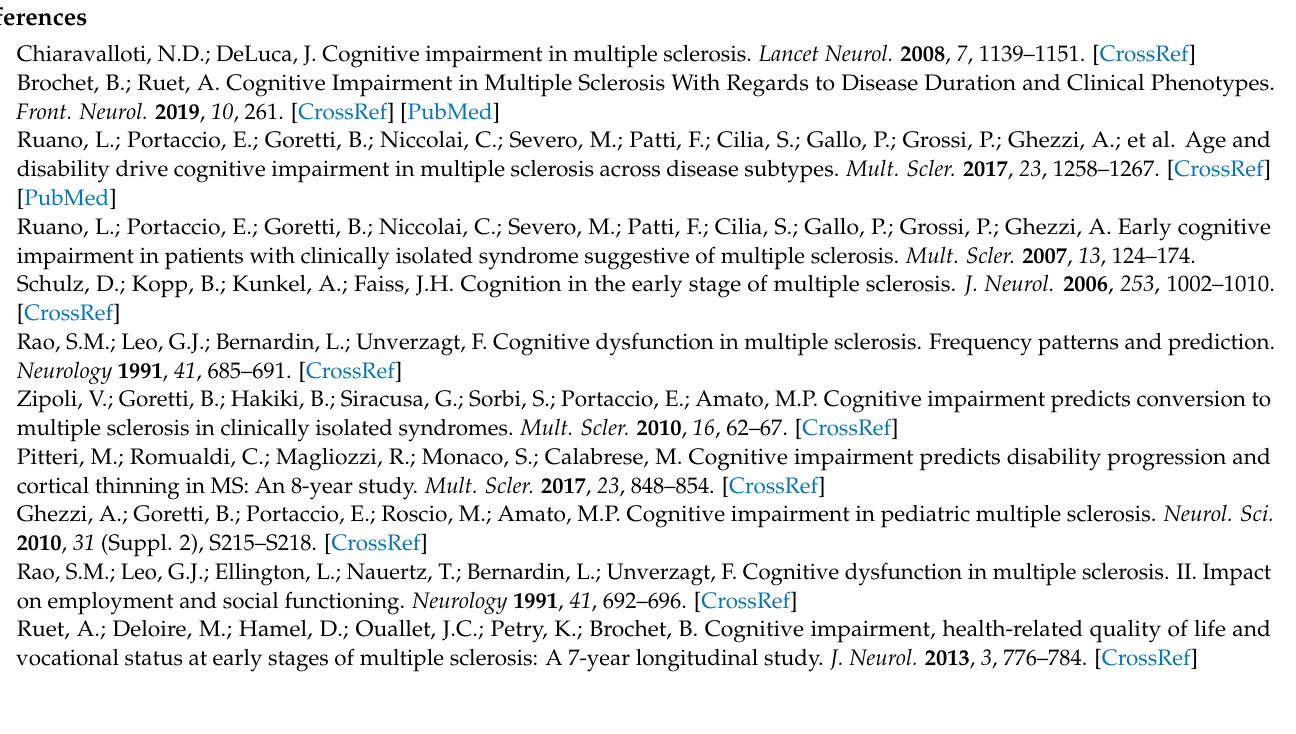
Gaussian shape both in time (temporal resolution) and in frequency (spectral resolution). Resolu- tion is given in units of FWHM (full width half maximum) for several frequencies. Figures S2–S3: Mean values and confidence intervals of latency (Figure S1) and amplitude (Figure S2) of the main ERPs by oddball paradigm in pwMS and HCs. Figure S4: Topographical representation of Grand Average of ERP-ERF peaks in 16 pwMS (above) and 19 HCs (below). From left to right: EEG-ERP, component. Figure S5: Deviant trial. Representative parietal midline gradiometer (a,b), magnetome- ter (c,d), and EEG derivation (e,f) for controls (top) and patients (bottom) The gradiometers showed a not significant increase in negative modulation induced by deviant stimulus in patients as compared to